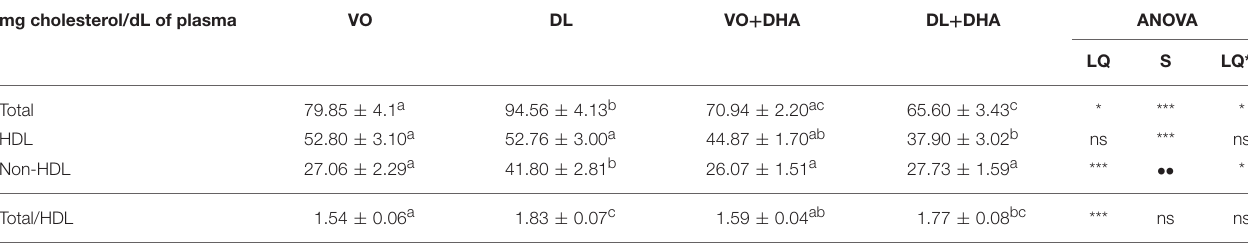
TABLE 4 | Plasma concentration of total cholesterol, HDL cholesterol and non-HDL cholesterol. mg cholesterol/dL of